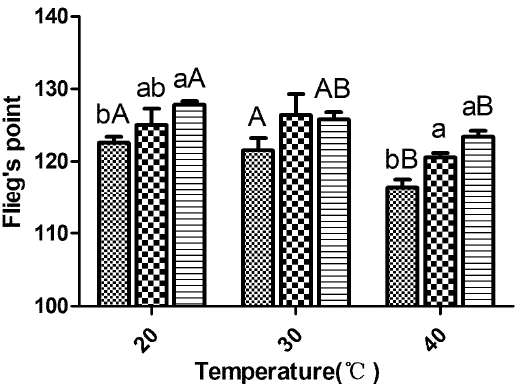
Figure 2. The Flieg’s point of sorghum silage. Control ; LF18, Lactobacillus farciminis inoculant ; LP23, Lactobacillus plantarum inoculant . Means within the same temperature (a, b) or within the same inoculant (A, B) with difference superscripts differ significantly from each other ( p < 0.05). Error bars indicate standard error of means.